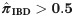
SMRU clinics on the Thai-Myanmar border.The border between Myanmar and Thailand (also the Moei river) is depicted in blue. Grey edges are proportional to inter-clinic proportions of highly related barcode parasite sample pairs (pairs with π^IBD>0.5). Latitudes and longitudes, respectively, are: 17.128107, 98.382152 (Maela); 16.83014, 98.53737 (Wang Pha); 16.5781479, 98.5846176 (Mae Kon Ken); 16.3258896, 98.670166 (Mawker Thai).